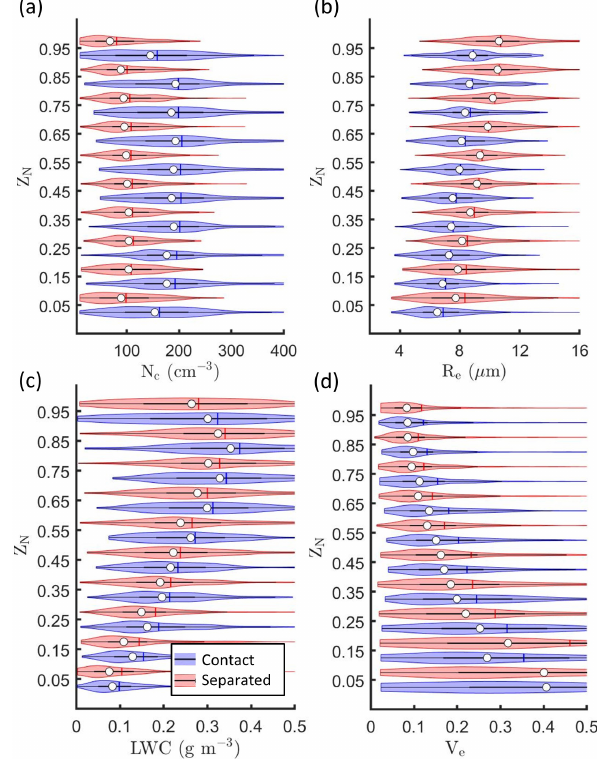
Figure 10. Kernel density estimates (indicated by the width of the shaded area) and boxplots showing the mean (vertical line) and me- dian (white circle) for (a) N c , (b) R e , (c) LWC, and (d) V e versus normalized height in cloud ( Z N ) for profiles with a MODIS retrieval co-located with in situ data for (cid:49)T less than 3600s.